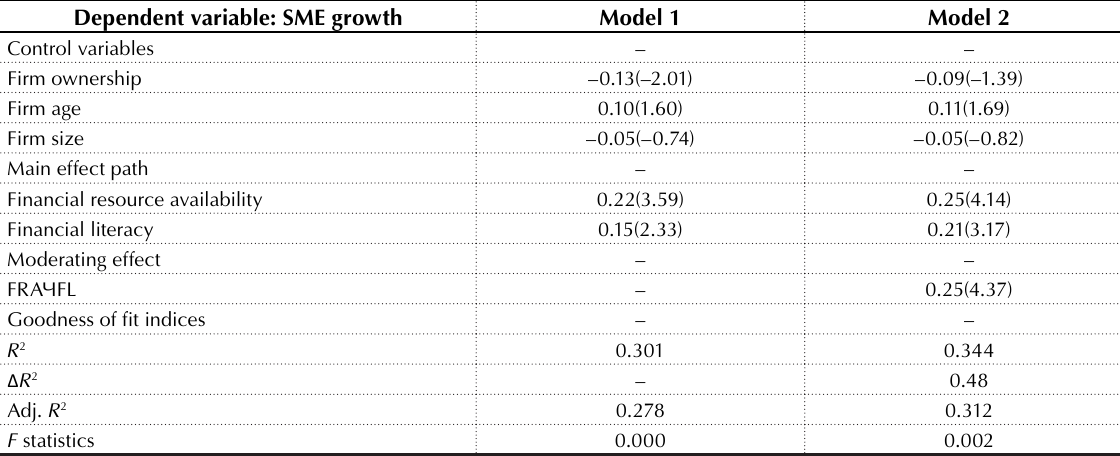
Table 5. Results of moderated regression analysis